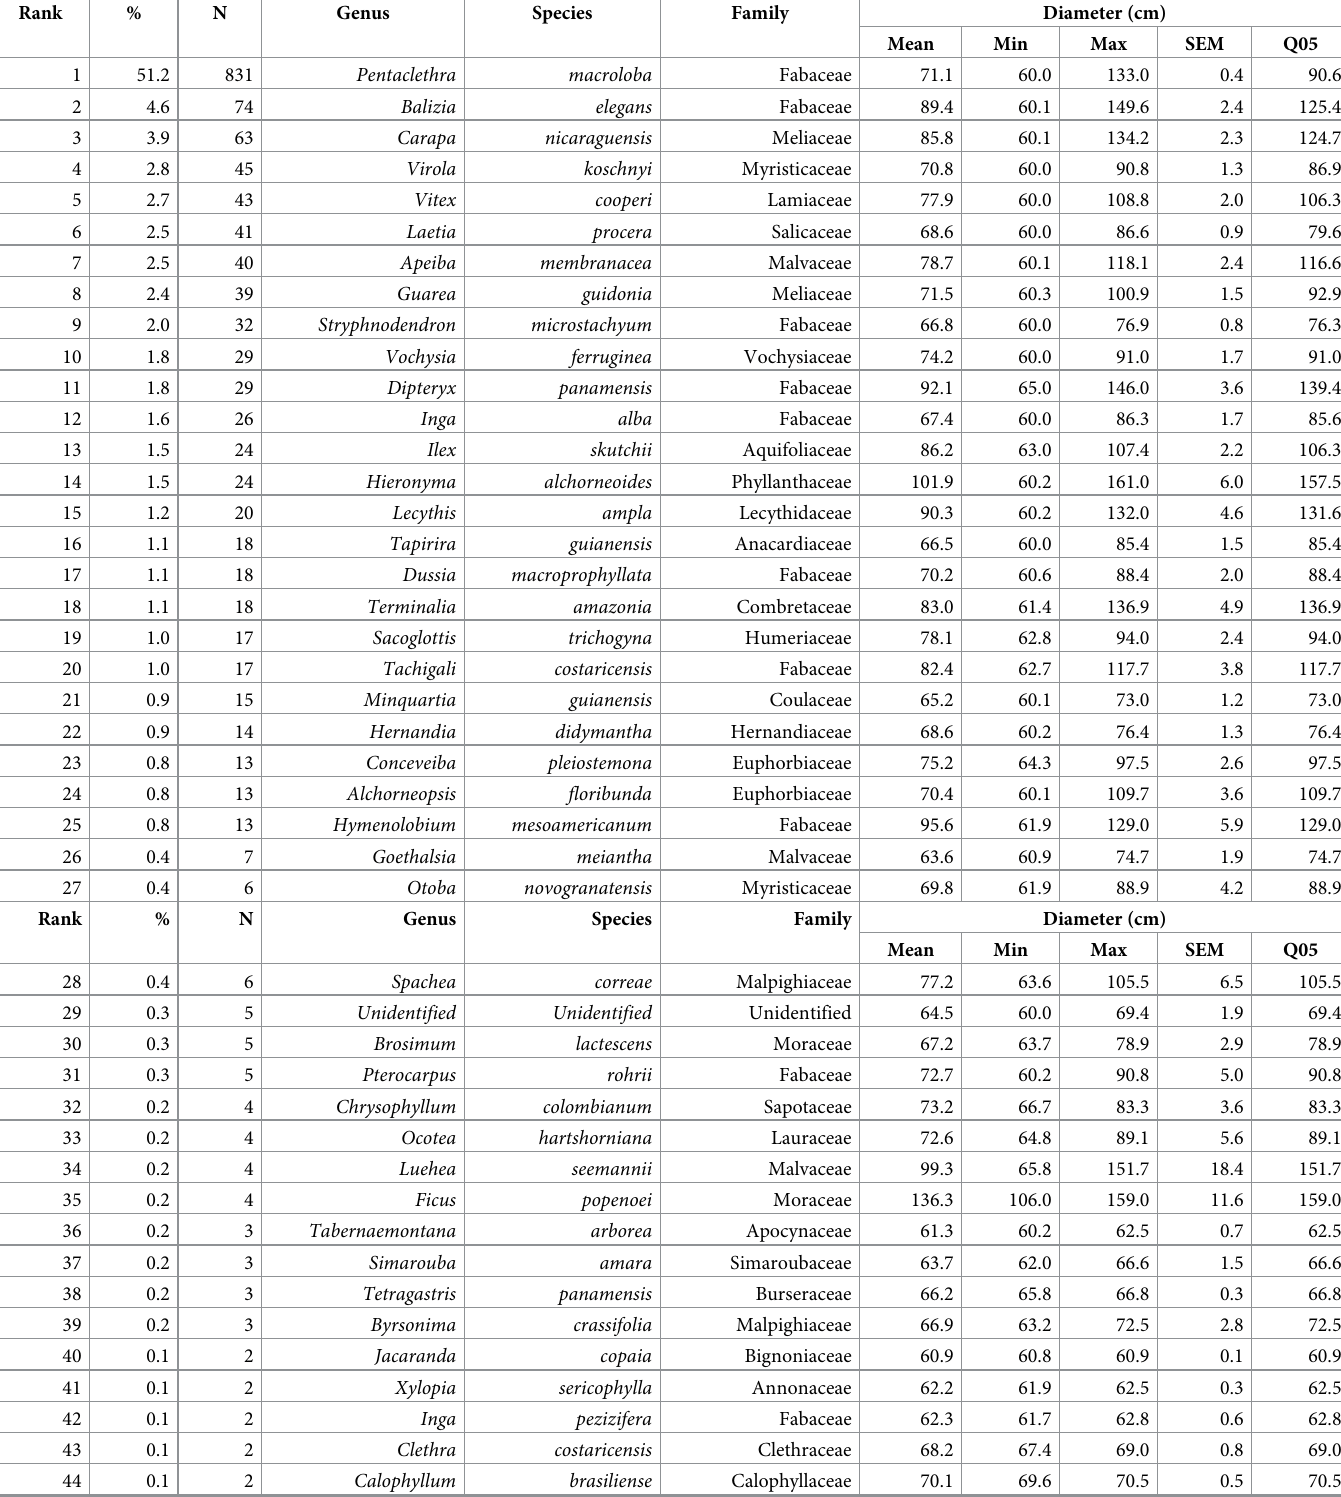
Table 2. Size and abundance of large tree